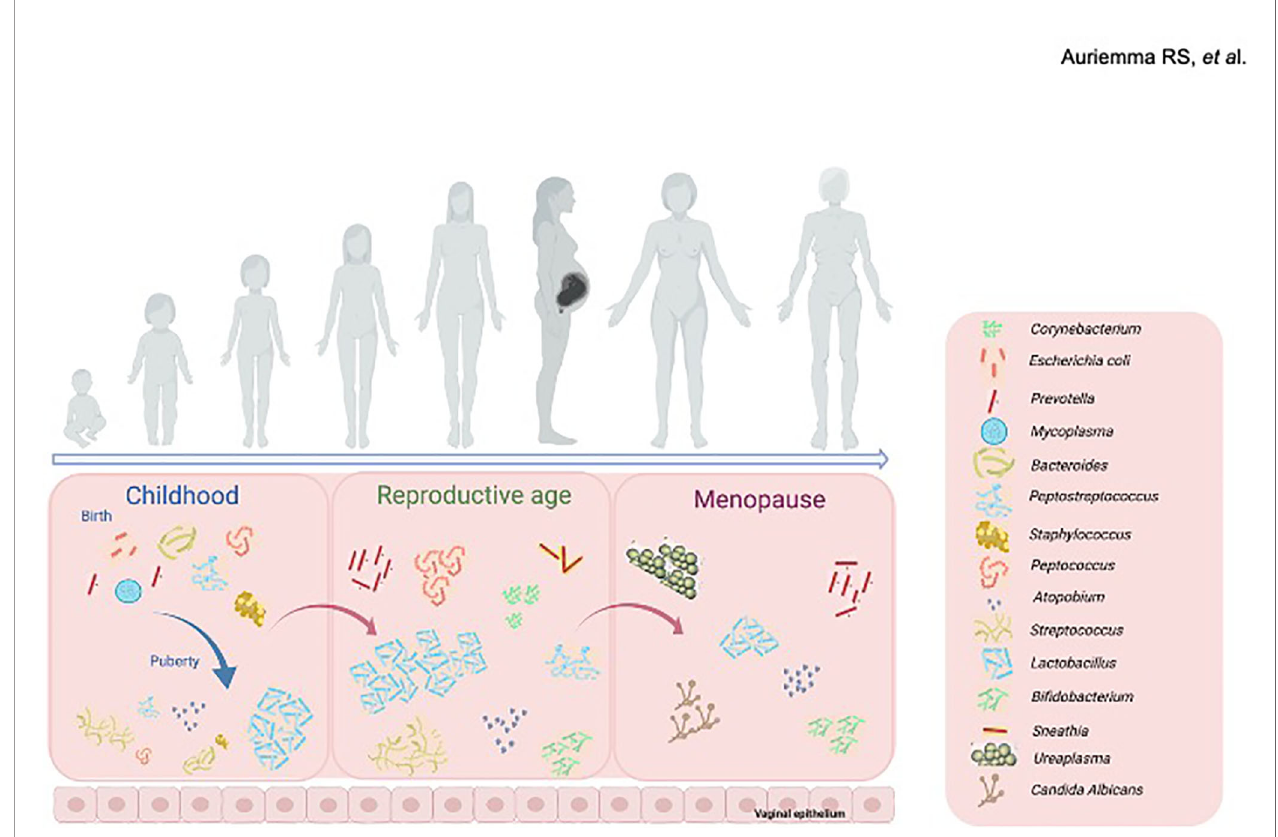
FIGURE 1 | Changes in the composition of vaginal microbiome throughout women life. In childhood (left panel), Corynebacterium spp., coagulase-negative Staphylococcus spp., Escherichia coli and Mycoplasma spp., form the vaginal microbiome. At puberty, upon estrogen/progestin exposure the vaginal microbial niche shifts towards other predominant colonies, mainly including Lactobacillus spp., Atopobium , and Streptococcus spp. During reproductive age (middle panel), vaginal microbiome houses a range of bacterial communities, mainly including lactobacilli ( L. crispatus, L. gasseri, L. jensenii and L. iners ) along with anaerobic bacteria. Menopause (right panel) induces further changes in the composition of vaginal microbiome, mainly composed by Gardnerella vaginalis , Ureaplasma urealyticum , Candida albicans and Prevotella spp., together with a progressive decrease in species of Lactobacillus . Created with